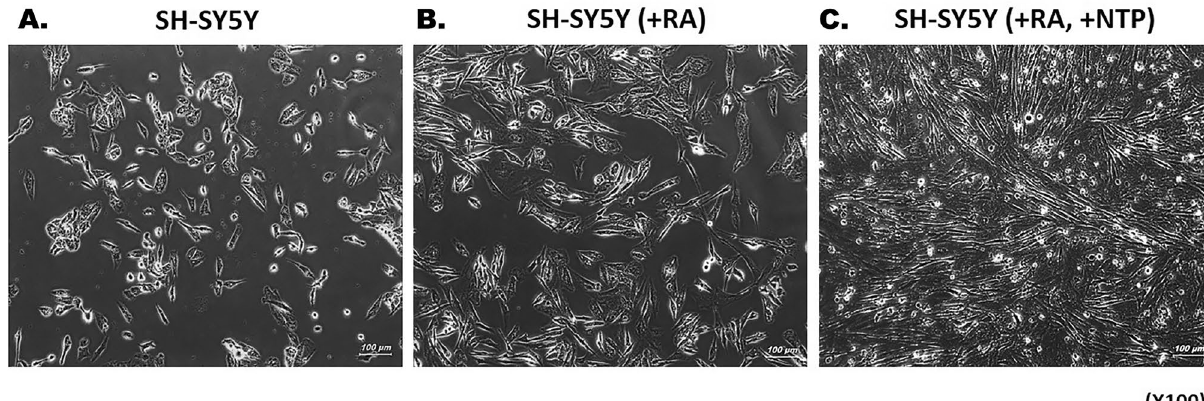
Figure 2. Optical microscope images of SH-SY5Y cells before and after RA/NTP treatment. ( A ) Cells before RA application (Undifferentiated normal SH-SY5Y Cell). ( B ) After 7 days of RA application, the extension of neurites was seen (Cells are differentiated). ( C ) After the NTP treatment on SH-SY5Y cells, the number of cells increased, and axonal elongation progressed further (NTP was processed 3 times a week).